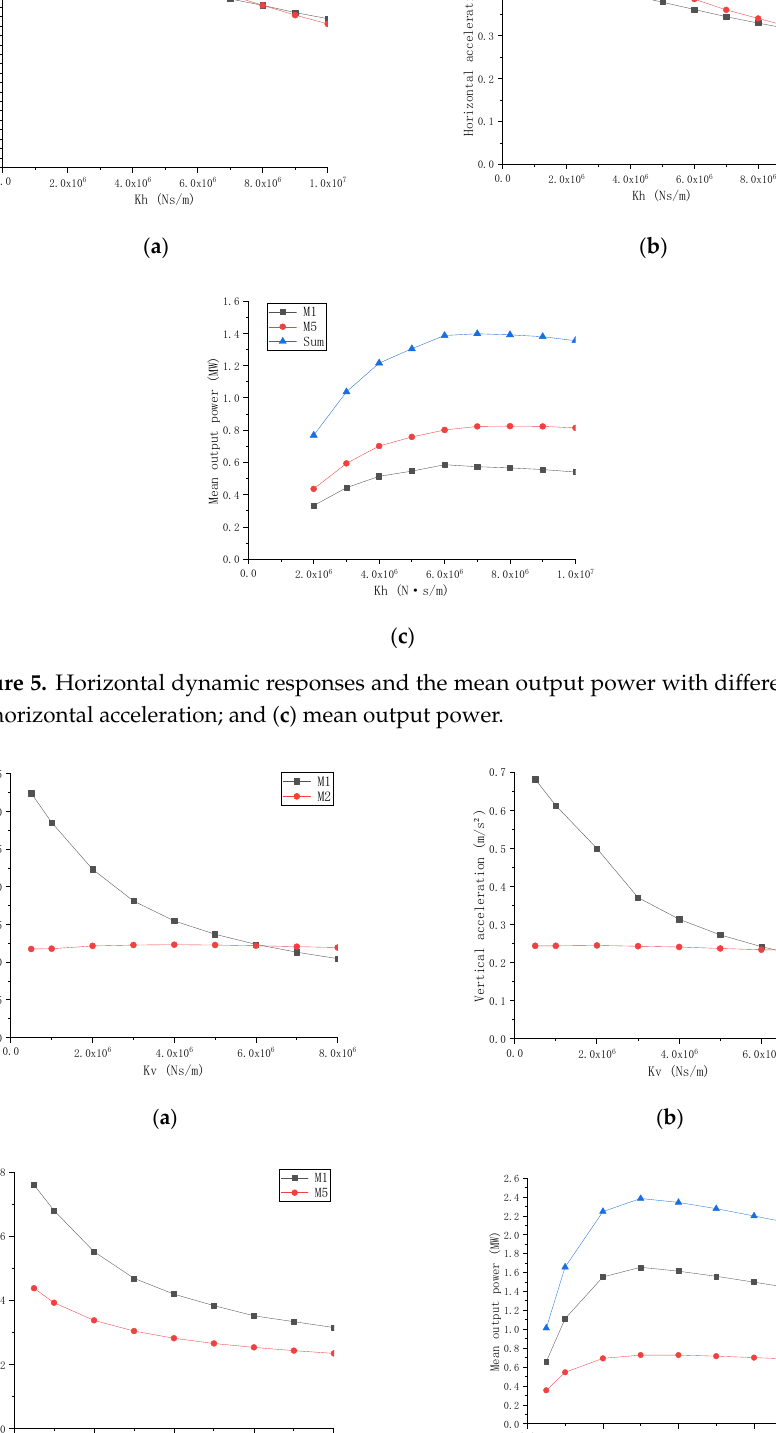
Figure 6. Vertical dynamic responses and the mean output power with different K v : ( a ) heave; ( b ) vertical acceleration; ( c ) pitch; and ( d ) mean output power.